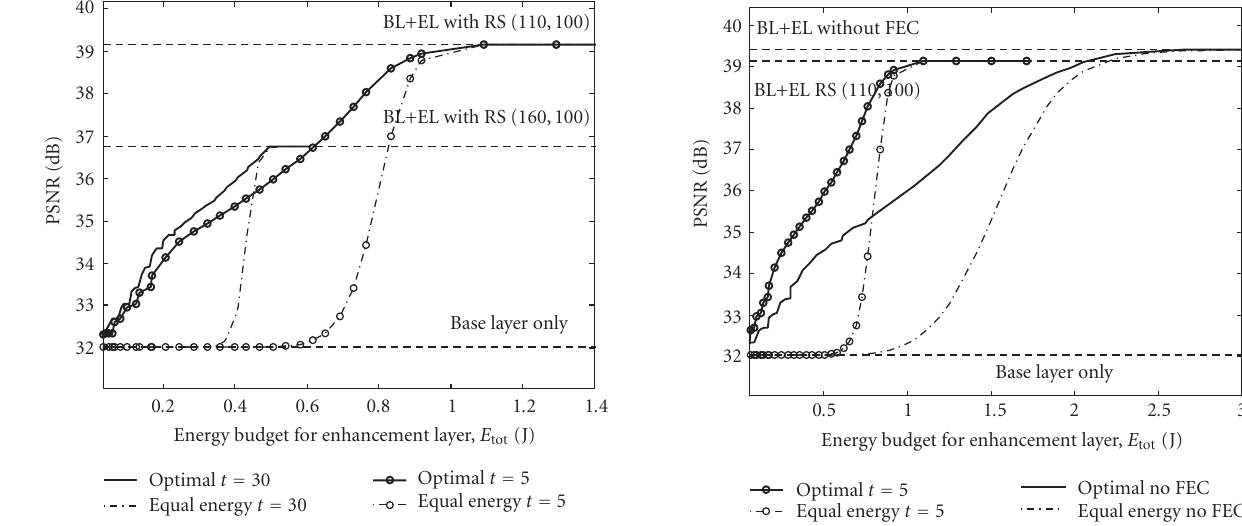
Figure 12: Performance improvement deriving by the introduction of RS(110,100) code (BPSK, B T =